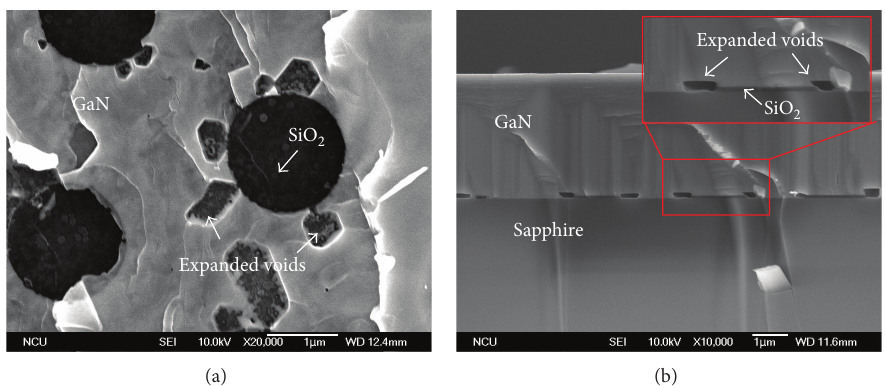
Figure 8: (a) The SEM image of sample-R lifted off by diamond cutter. (b) The cross-sectional SEM image of